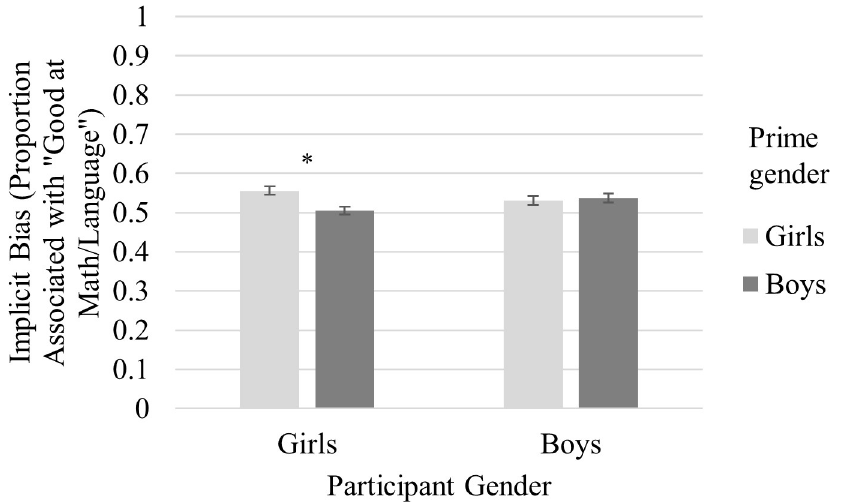
Fig 1. Estimated marginal means for implicit bias scores by participant gender. Values indicate the proportion each prime gender associated with “good at math” or “good at language arts.” Bars represent standard errors.